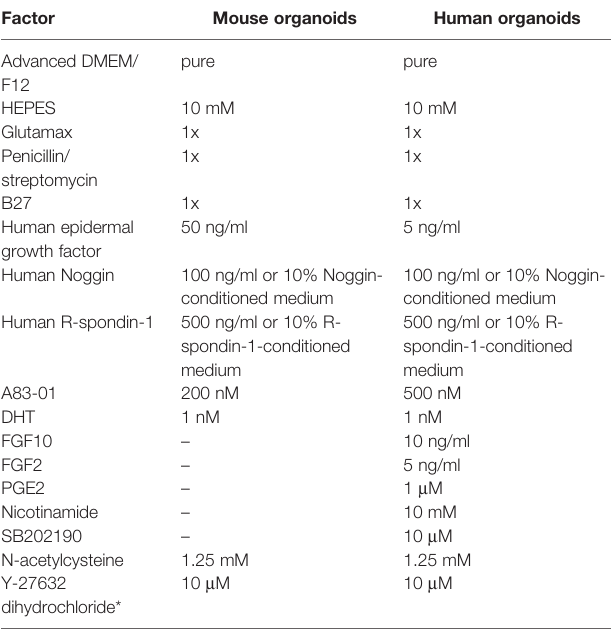
TABLE 2 | Summary of culture medium components for mouse and human prostate organoids (27, 28). Factor Mouse organoids